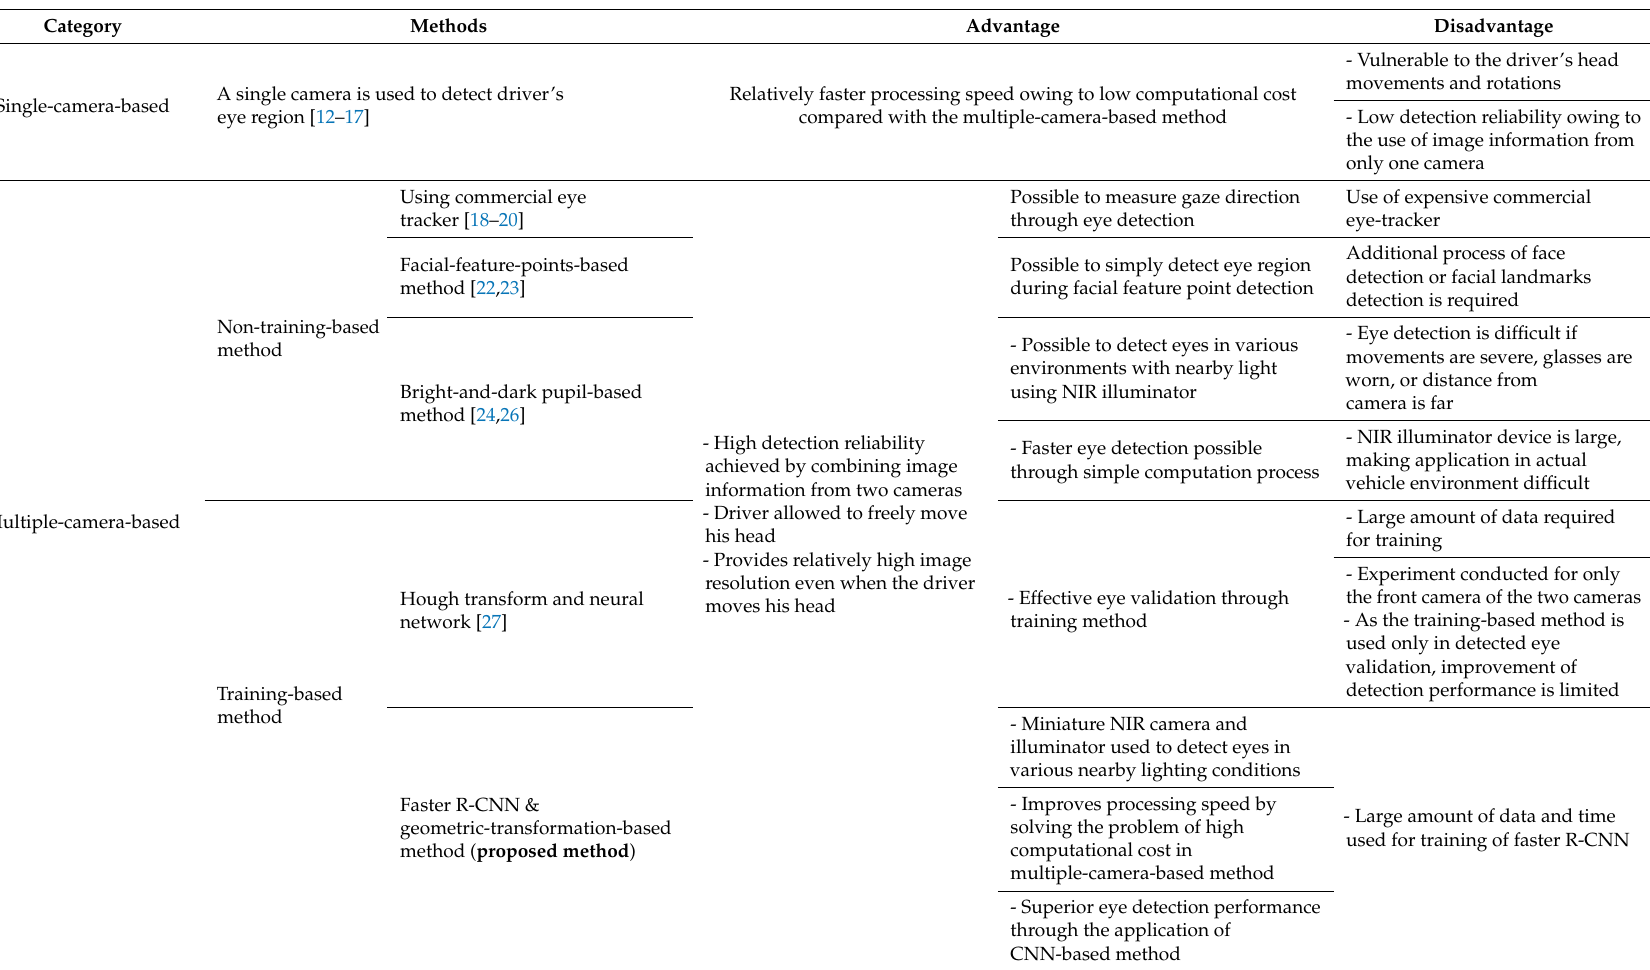
Table 1. Comparison between existing methods and the proposed method for eye detection in vehicle